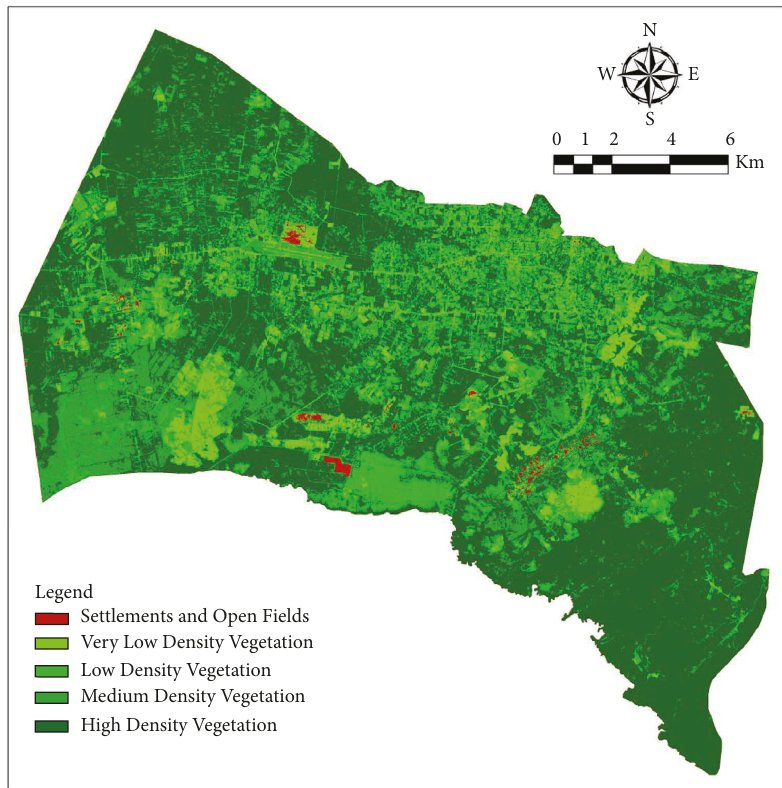
Figure 3: Map of vegetation density in Banjarbaru